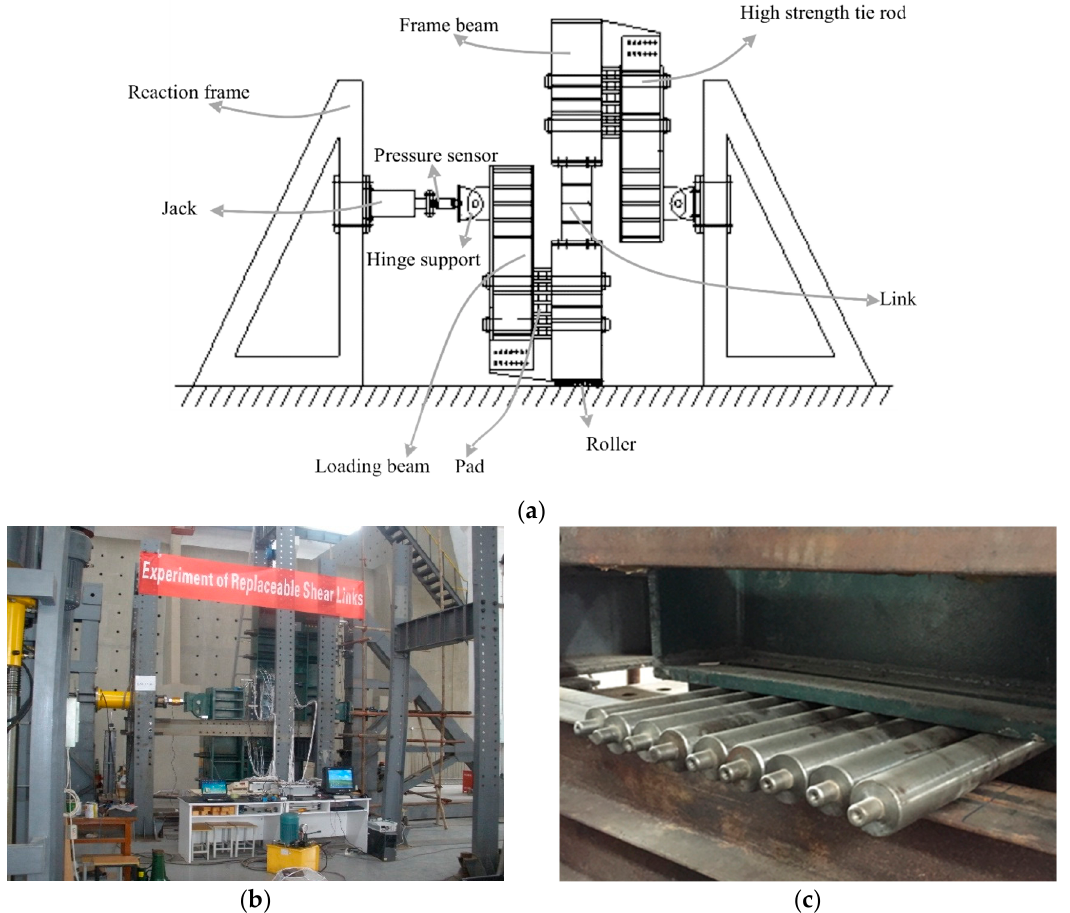
Figure 3. Experimental setup. ( a ) Details of test setup; ( b ) Photo; ( c ) Roller.